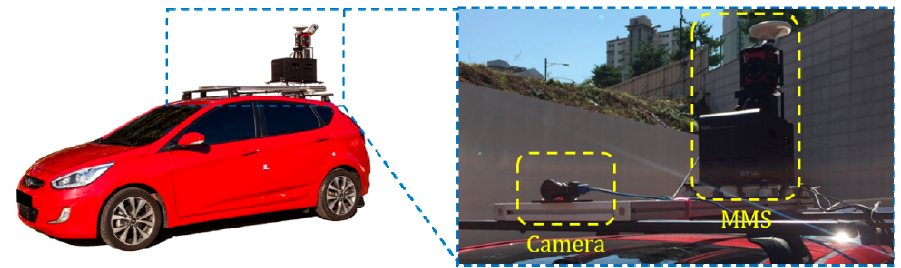
Figure 7. MMS and camera used in the experiment.